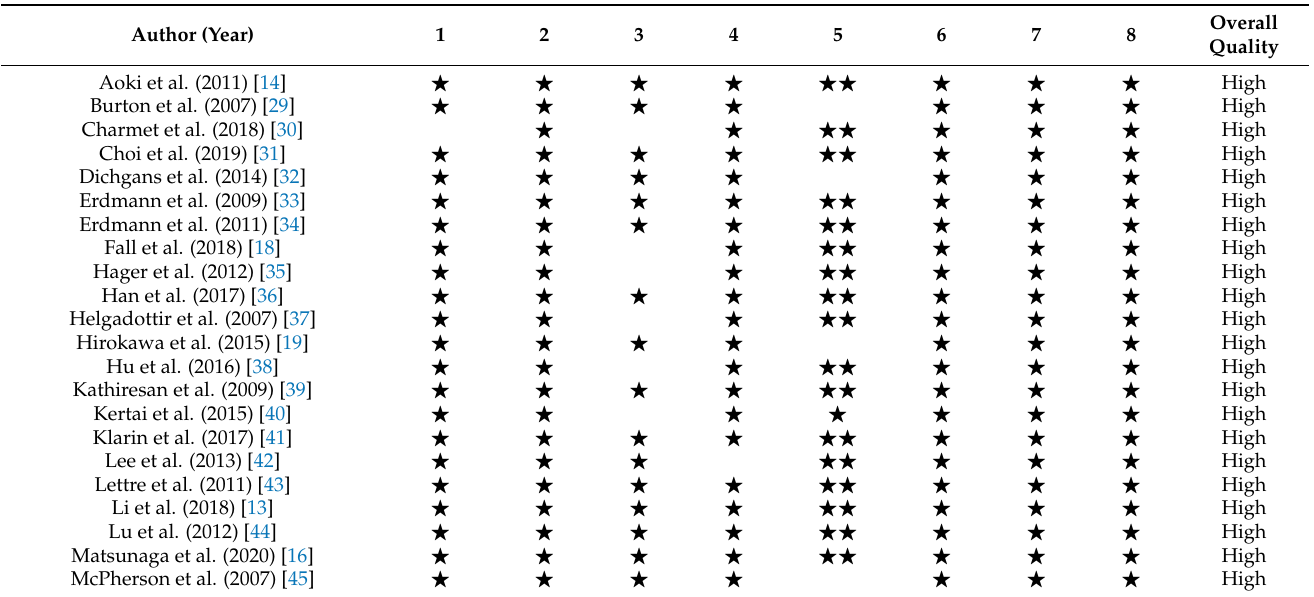
Table 2. Quality assessment according to the Newcastle–Ottawa Quality Assessment Form for Case–Control